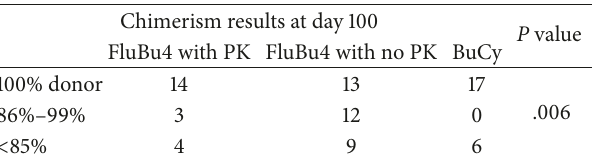
Table 3: Total donor chimerism on day